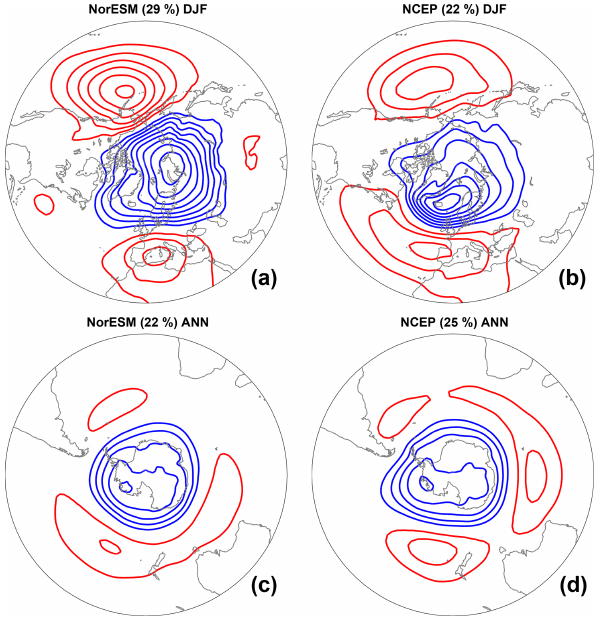
Figure 13. (a, b) Leading empirical orthogonal function (EOF) of the winter (DJF) mean sea level pressure (SLP) anomalies over the NH (20–90 ◦ N) for (a) the historical run (years 1976–2005) and (b) NCEP-2 data of the same period. (c, d) Leading EOF of the monthly mean SLP anomalies over the SH (90–20 ◦ S) for (c) the historical run (years 1976–2005) and (d) NCEP-2 data of the same period. The SLP patterns are obtained by regression of anomalies on the leading principal component time series. The contour intervals in all panels are 1hPa, with the zero line omitted.